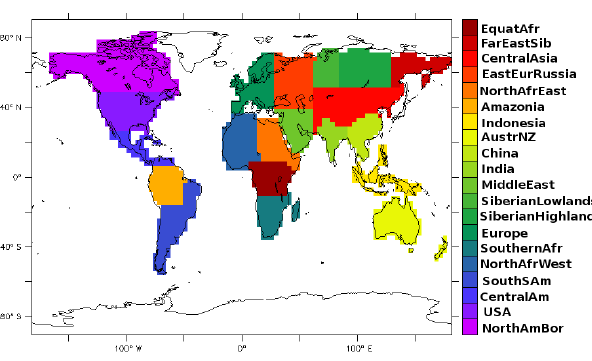
Figure 2. Regions on the model grid, adapted to key areas for methane